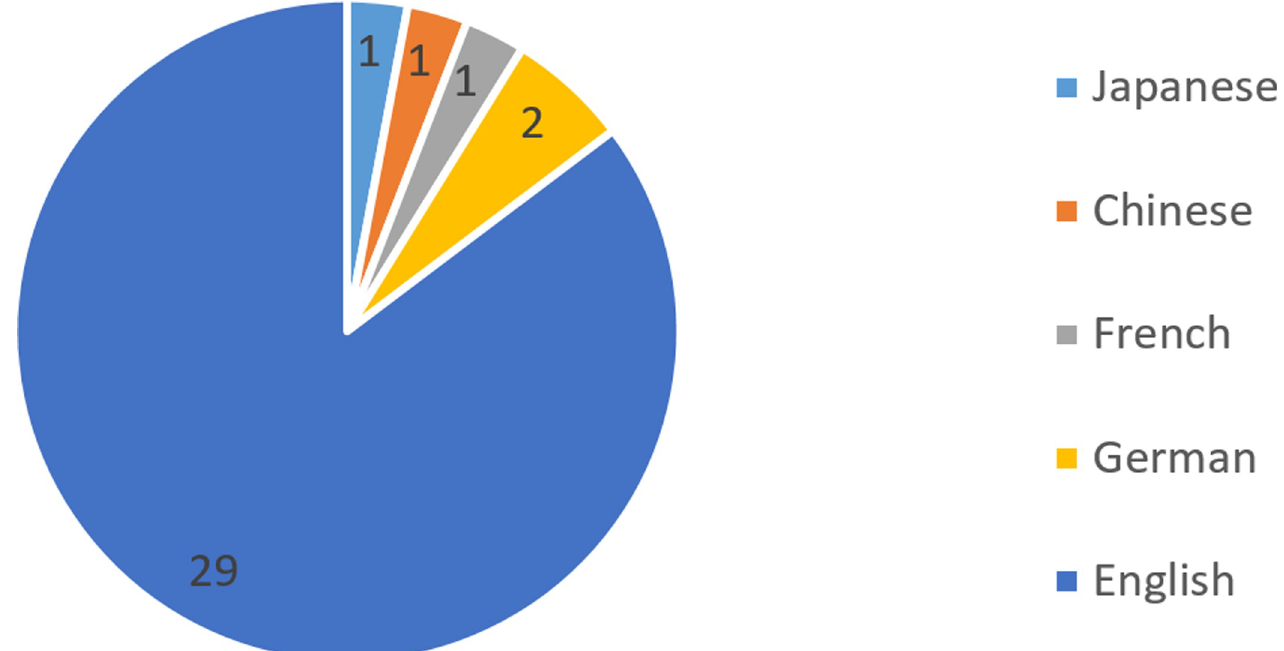
Fig 2. Types of the target